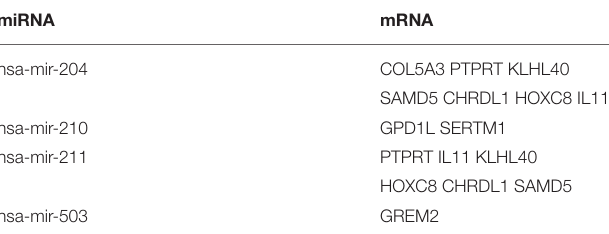
TABLE 5 | The miRDB, miRanda, and TargetScan database revealed interactions between DEmiRNAs and DEmRNAs. miRNA